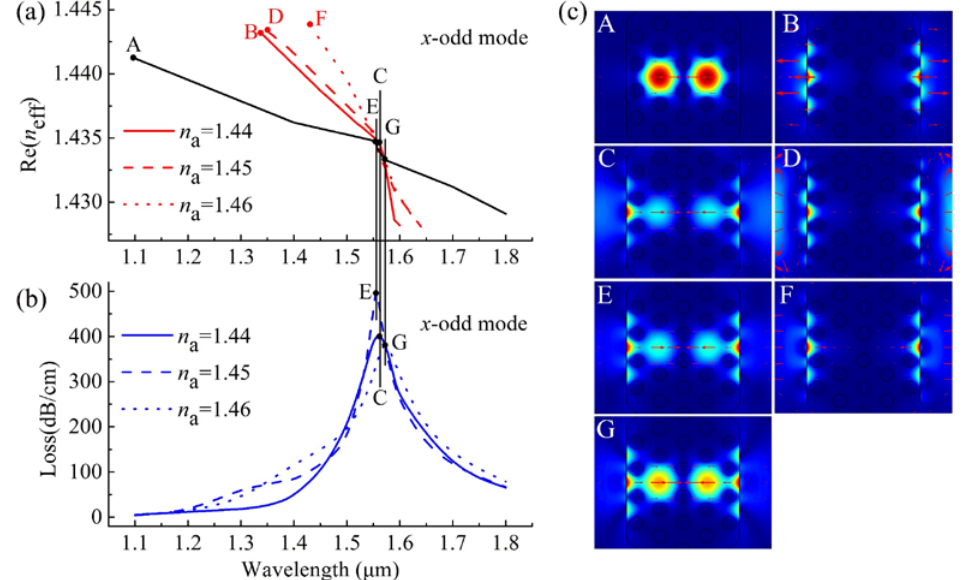
Figure 4. ( a ) The Re ( n eff ) curves of the x -odd core modes (black lines) and x -odd SPP modes at n a = 1.44, 1.45,and 1.46 represented by the red solid, dashed, and dotted lines, respectively; ( b ) the loss spectra of the x -odd core modes at n a = 1.44, 1.45, and 1.46 represented by the blue solid, dashed, and dotted lines, respectively; ( c ) electric field distributions of the x -odd core mode A at 1100 nm, the x -odd SPP mode B at 1340 nm, and the x -odd core mode C at 1561 nm for n a = 1.44, electric field distributions of x -odd SPP mode D at 1350 nm and x -odd core mode E at 1556 nm for n a = 1.45, and electric field distributions of x -odd SPP mode F at 1430 nm and x -odd core mode G at 1572 nm for n a = 1.46.